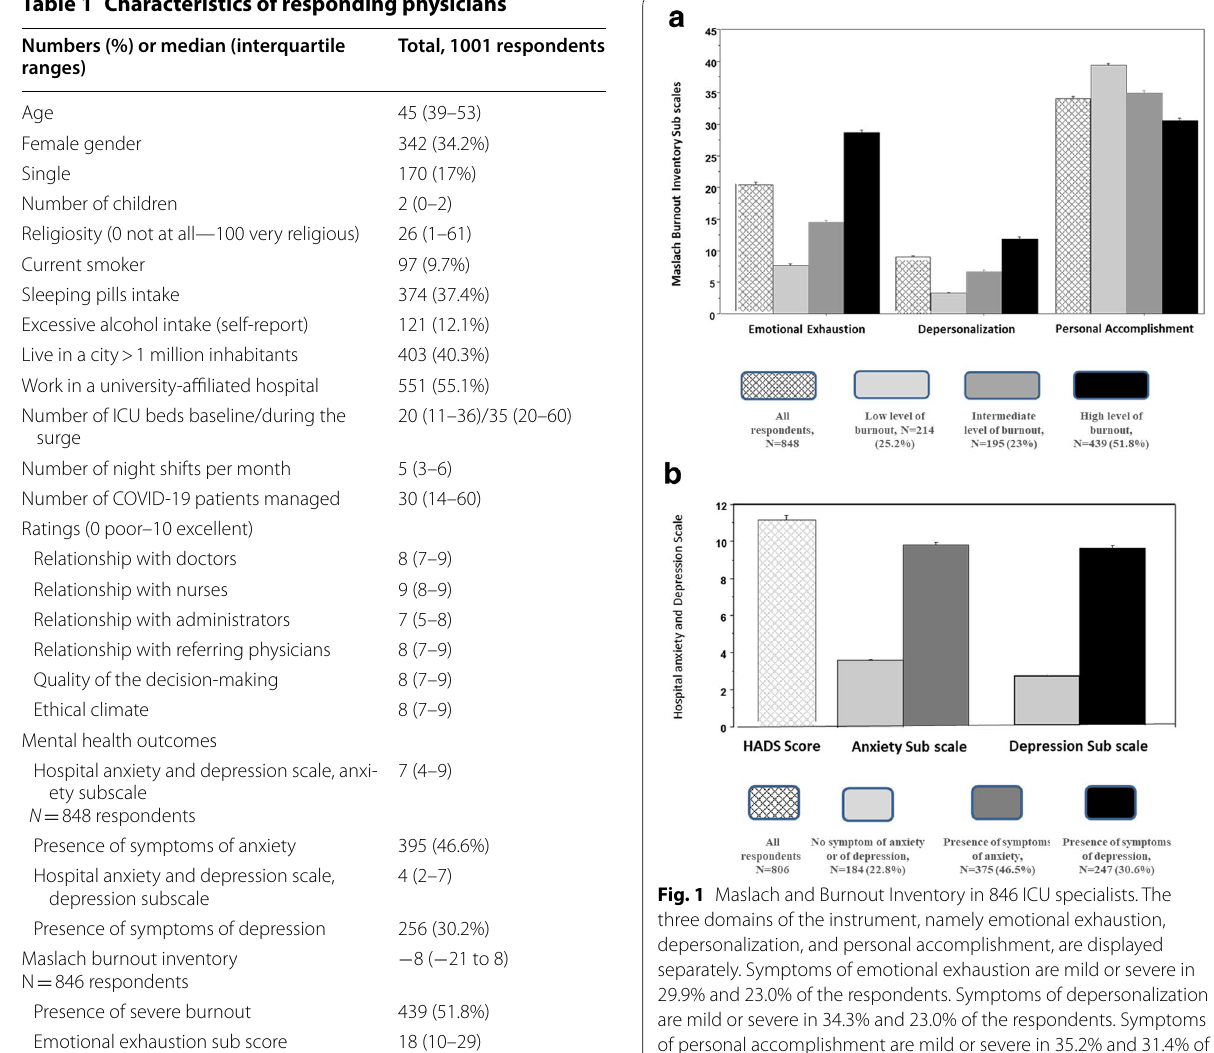
Table 1 Characteristics of responding physicians